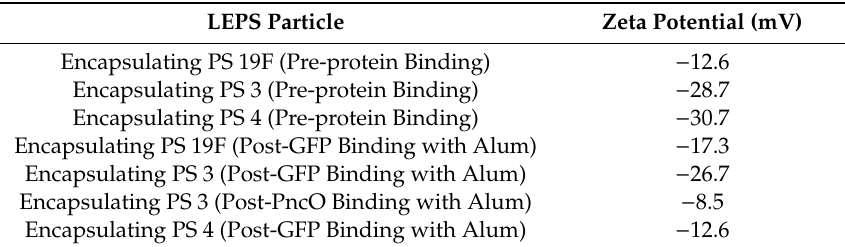
Table 1. LEPS surface charge